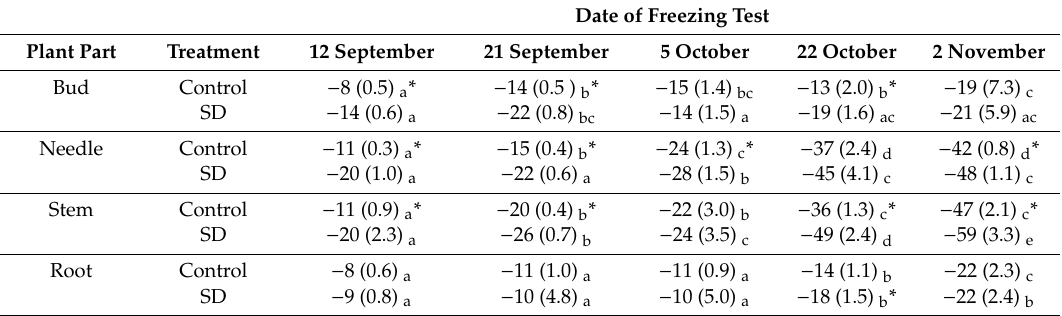
Table 2. Frost hardiness (describes plants’ ability to tolerate low temperatures), determined as DT 50 (the temperature causing damage or growth reductions to 50% of the plant part in question) of di ff erent plant parts in 1.5 year old Norway spruce seedlings that were grown either under a natural photoperiod (control) or that received a short-day treatment (SD) (mean ± SE, n = 4). The data were subjected to a nonlinear mixed model (NLMIXED). Asterisks indicate di ff erences between the treatments within each exposure date ( p < 0.05). Di ff erent letters after the values denote di ff erences between the exposure dates within the treatments ( p < 0.05).